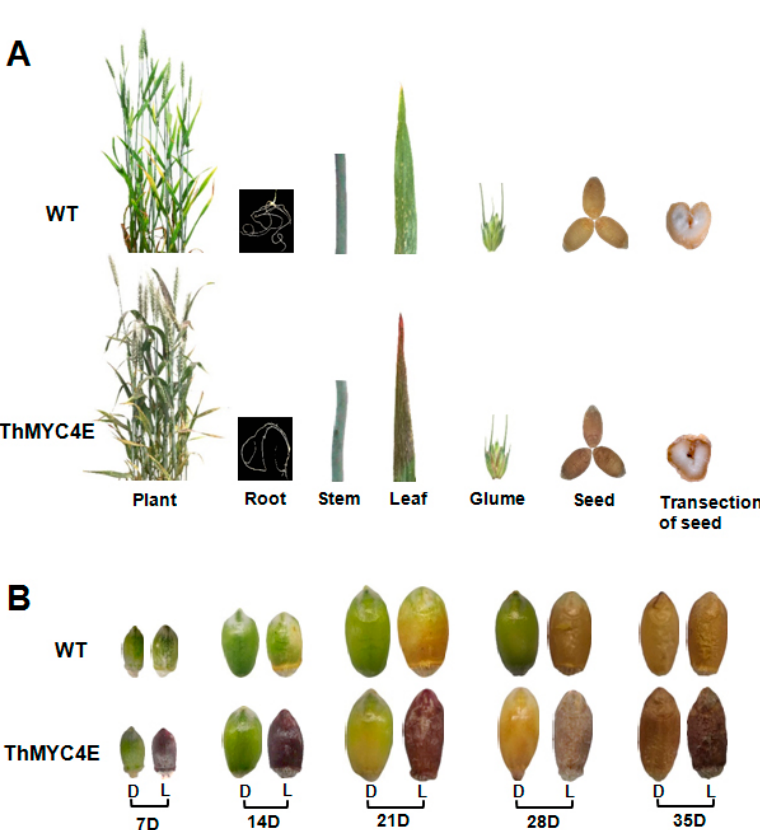
Figure 1. Photograph of transgenic lines and WT under normal conditions and light treatment. ( A ) Photograph of the whole plant and different tissues of transgenic lines and the WT. The transection of seed was form 35 day old fully mature seeds. ( B ) The grains at one week intervals after flowering. 7D = 7 days after flowering, and so on. D = dark treatment (control), while L = light treatment. 2.2. RNA-Seq and qPCR Indicated that Phenylalanine Biosynthesis and Flavonoid Biosynthesis Were